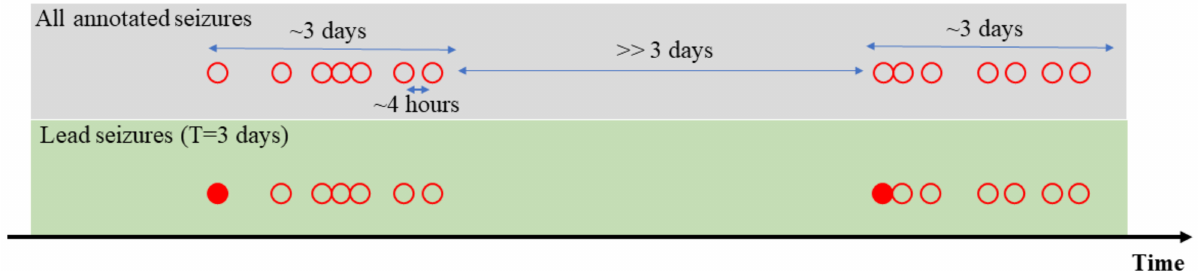
Figure 1. Lead seizures of seizure clusters. Fourteen seizures are annotated in the recording period (represented as 14 red circles); Using T = 3 days, two of them are defined as lead seizures (represented as filled red